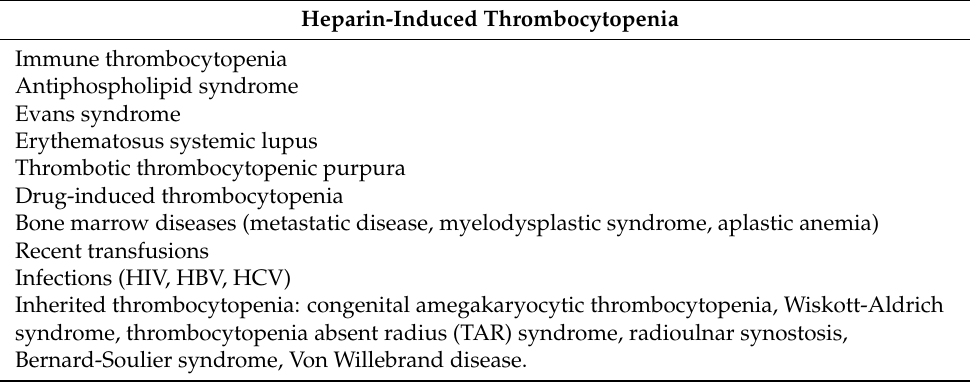
Table 2. Clinical conditions associated with immune thrombocytopenia and possible